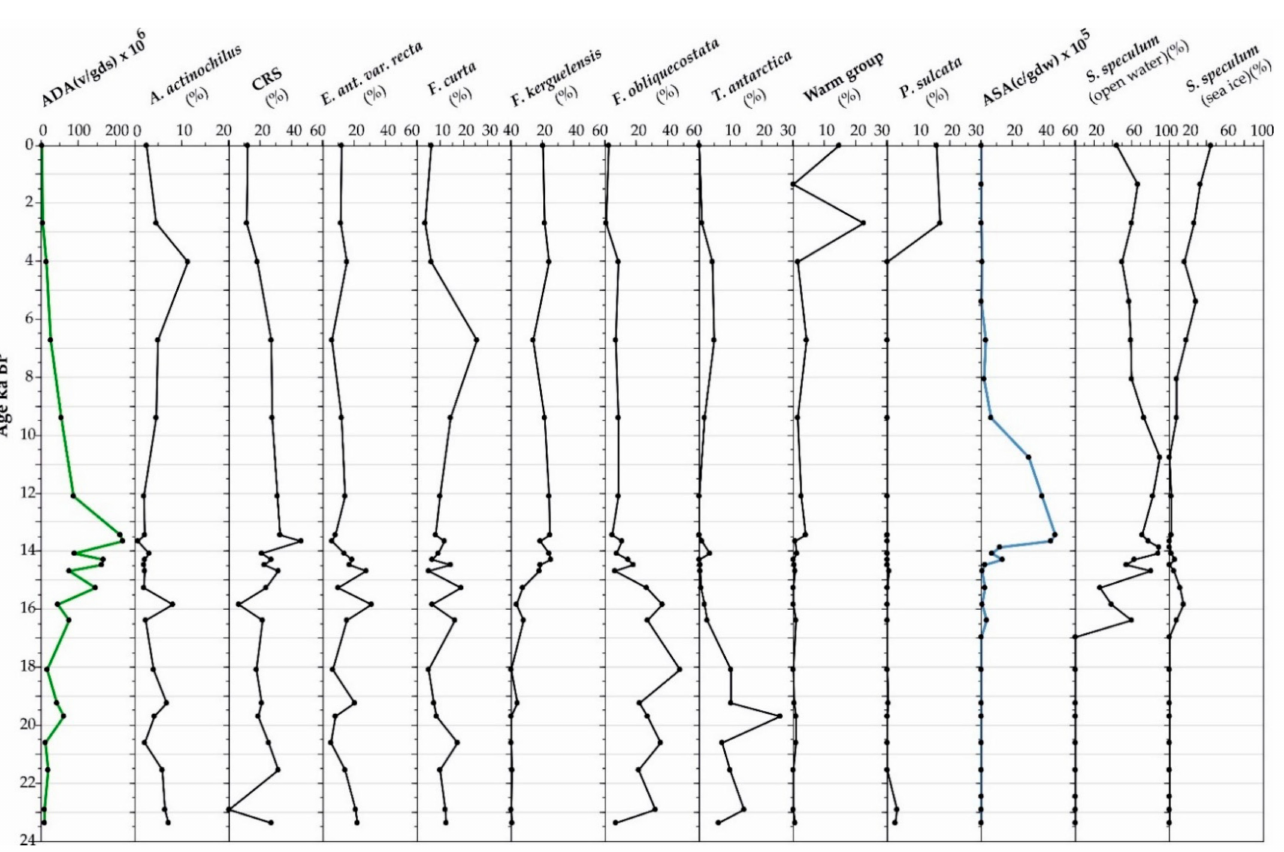
Figure 10. Down-core distribution of diatom and silicoflagellate present in BC04. The variety S. speculum var. monospicata and var. bispicata , with var. speculum , represent the open ocean, while S. speculum var. coronata represents the marginal ice zone and the Ross Sea coastal